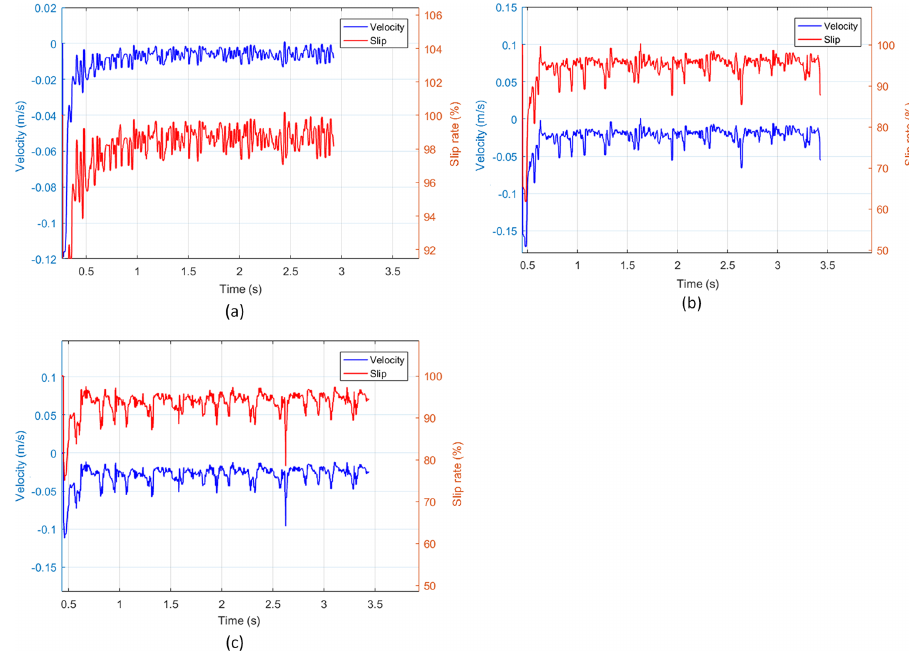
Figure 21. Velocity and slip rate at different initial depths. (a) Initial depth is 0.06m. (b) Initial depth is 0.52m. (c) Initial depth is 1.02m.